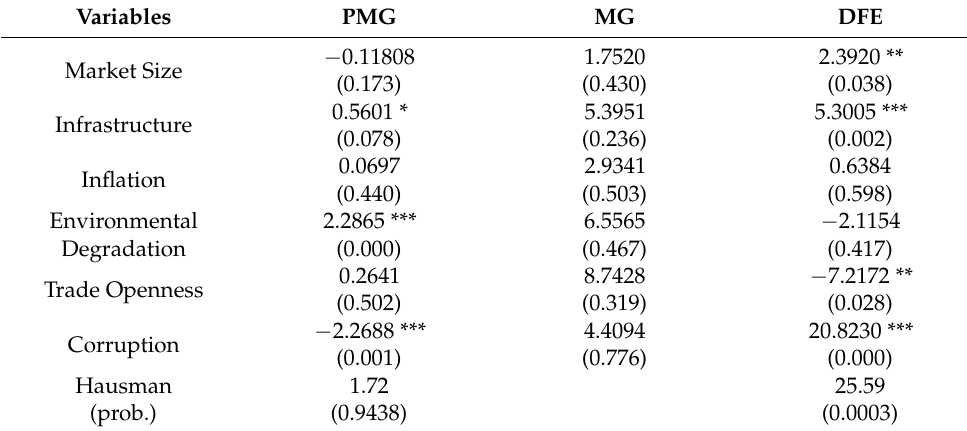
Table 6. Long-Run Estimation Results